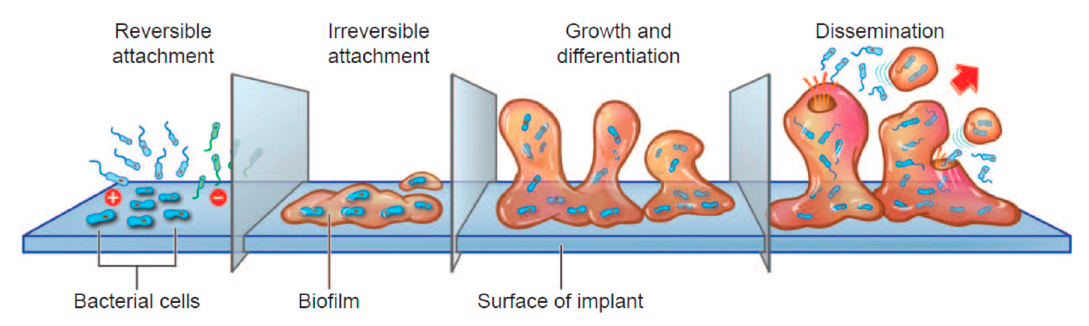
Figure 1. Stages of biofilm growth [78].